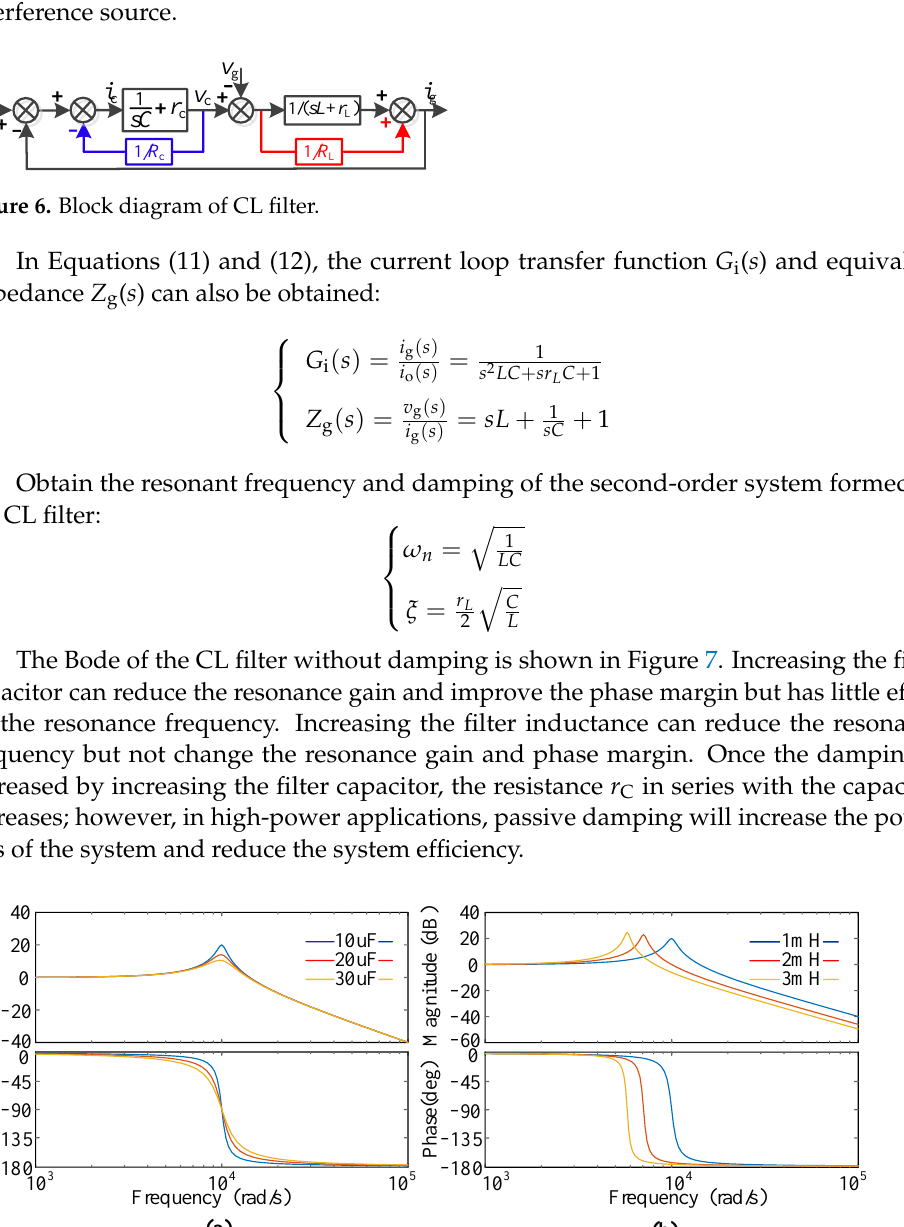
( a )( b ) L Figure 5. Equivalent circuit of CL filter: ( a ) CL filter without internal resistance and voltage Hall resistance; ( b ) CL filter with internal resistance and voltage Hall resistance.